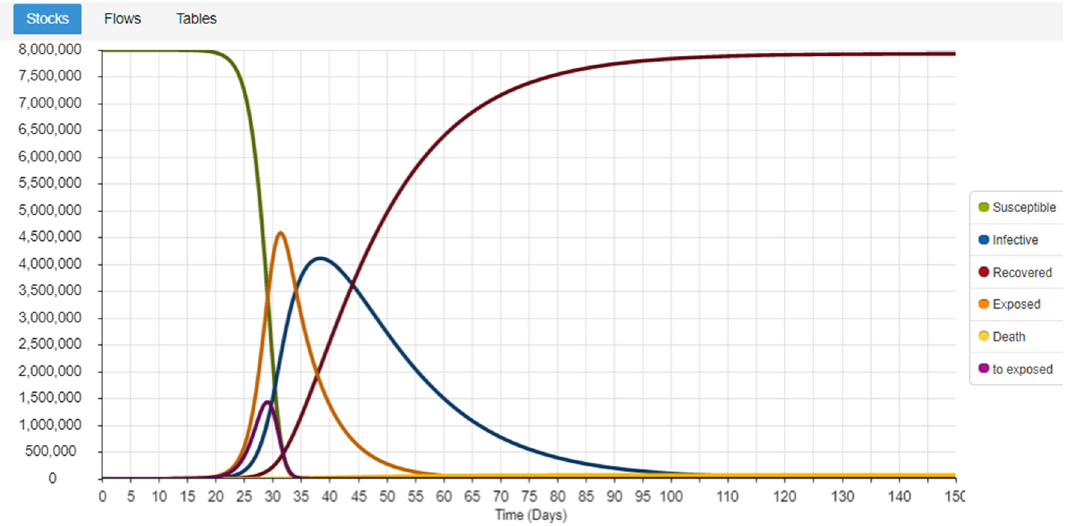
Figure 3. Preliminary values for the System Dynamics SEIRD model.